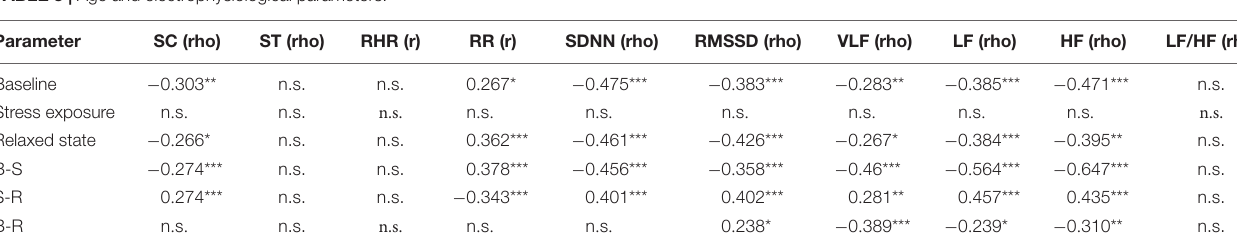
TABLE 3 | Age and electrophysiological